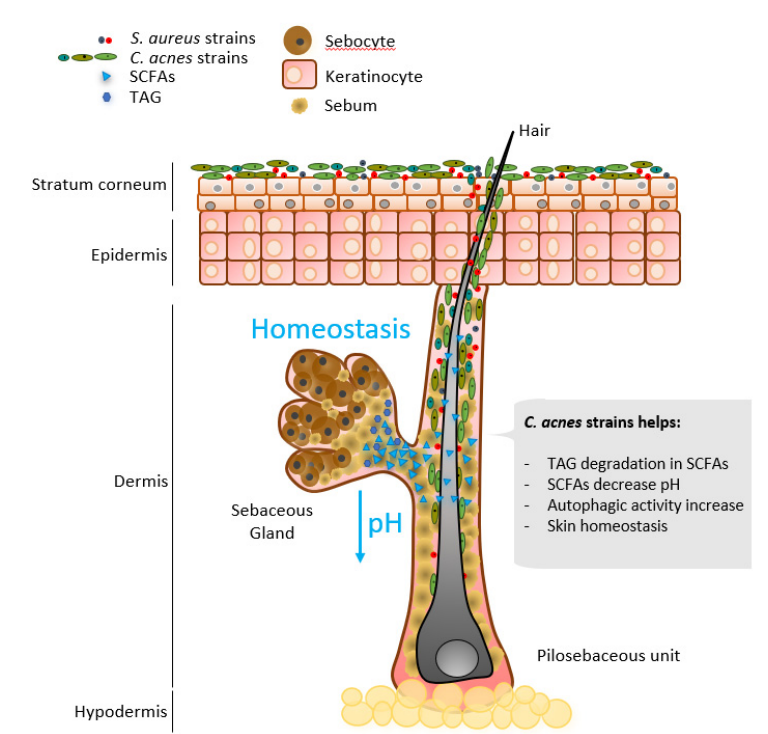
Figure 3. Selected Cutibacterium acnes major contributions in skin homeostasis.